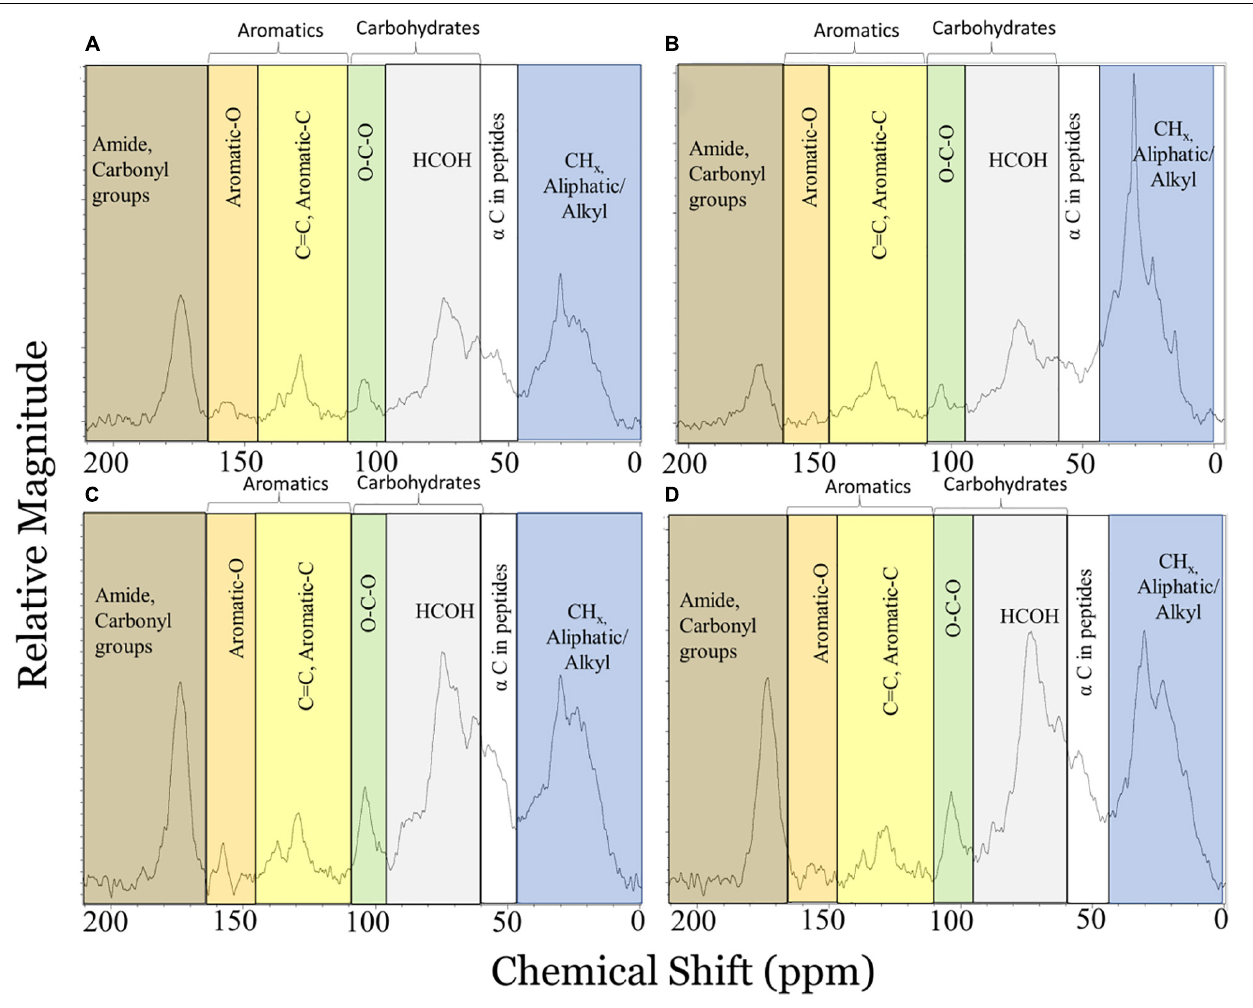
FIGURE 3 | Solid-state 13 C NMR spectra using a quantitative multiple cross polarization magic angle spinning pulse sequence for marine oil snow particles collected from the bottom of tanks in mesocosm control (A,C) and chemically-enhanced water accommodated fraction (B,D) treatments before (A,B) and after (C,D) extraction with dichloromethane to remove oil components. Shaded portions of the spectra represent chemical shift regions where signal for carbonaceous functional groups typically appear (blue: 0–45 ppm, aliphatic C; white: 46–60 ppm, α C in peptides; gray: 60–95 ppm, carbohydrate HCOH; green: 90–110 ppm, carbohydrate anomeric C; yellow: 110–145 ppm, Aromatic-C; orange: 145–165 ppm, Aromatic-O; brown: 165–215 ppm, Amide, Carbonyl C). Adapted from Hatcher et al.